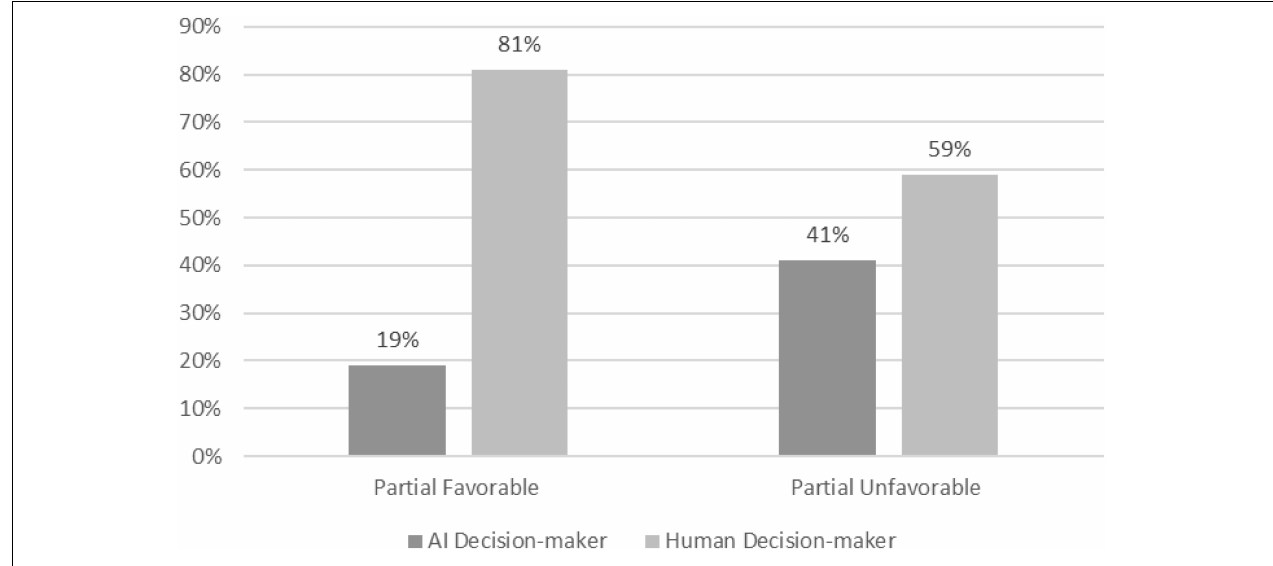
FIGURE 2 | Preferences for AI decision-makers in favorably biased vs. unfavorably biased conditions (Study 3). χ 2 (1), ( N = 318) = 18.62; p <